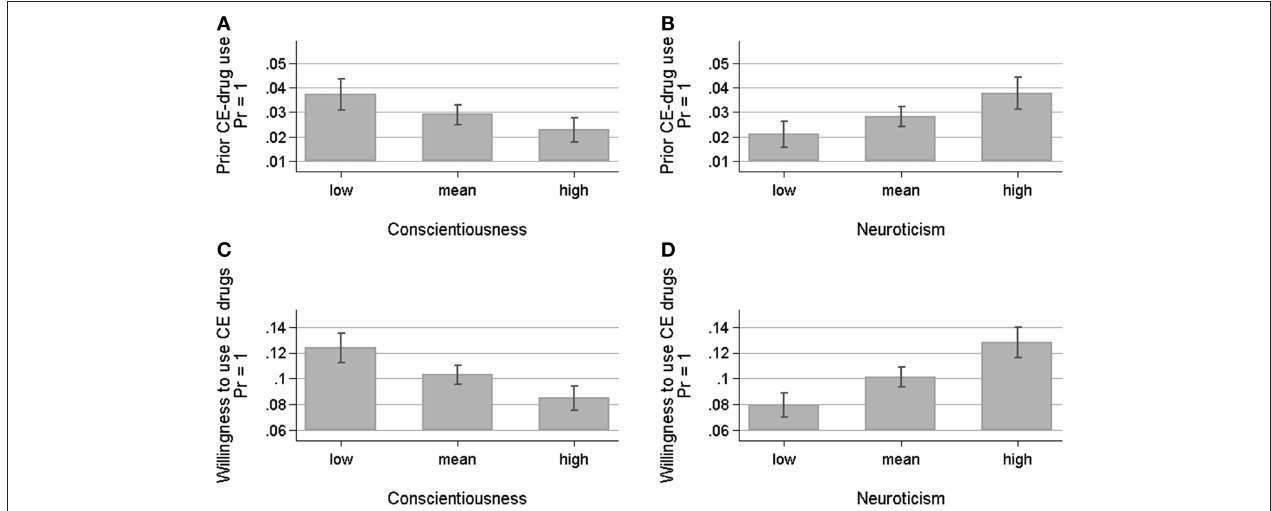
FIGURE 1 | Predicted probabilities of prior use and willingness (both y-axis) estimated using average marginal effects based on multivariate logistic regression models—error bars represent the 95% confidence interval. (A) shows that the predicted probability of prior CE-drug use is higher in case of lower conscientiousness [defined by the mean value (M) − 1 standard deviation (SD)] compared to theM and to higher conscientiousness (M + 1 SD), while the probability (B) is lower for lower levels of neuroticism (M – 1 SD) compared to theM and to higher neuroticism (M + 1 SD) (based on Model 1, Table 2 ). (C,D) show similar effects for the willingness to use CE drugs (based on Model 2, Table 2